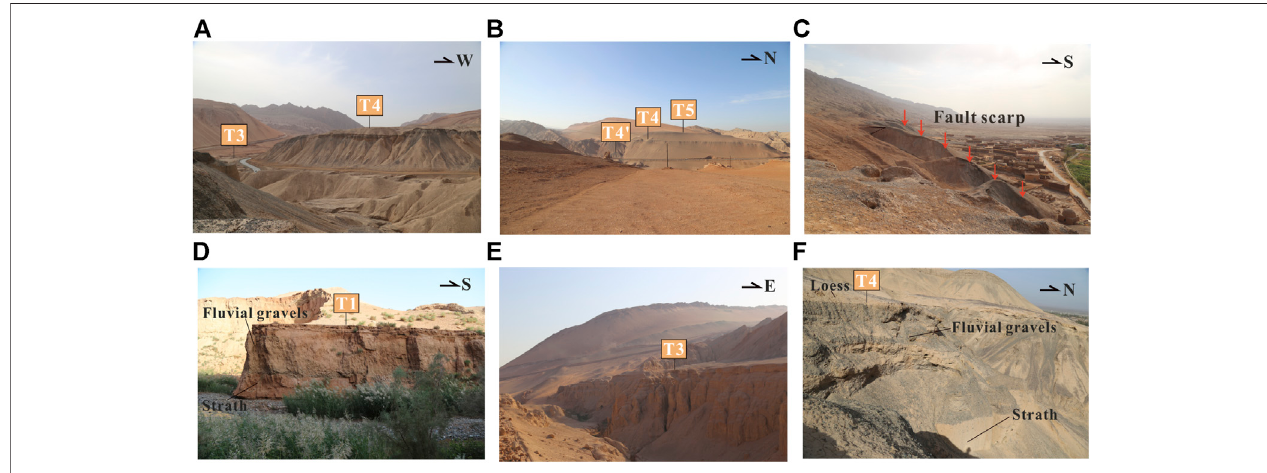
FIGURE 4 | (A) , (B) Views W and N of the river terraces preserved in the Tuyugou Valley. (C) The location of the main E-W fault scarp is shown by red arrows. (D) , (E) and (F) Close-up views S, E, and N of the river terraces preserved in the Tuyugou Valley (for all locations, see Figure 3A ).